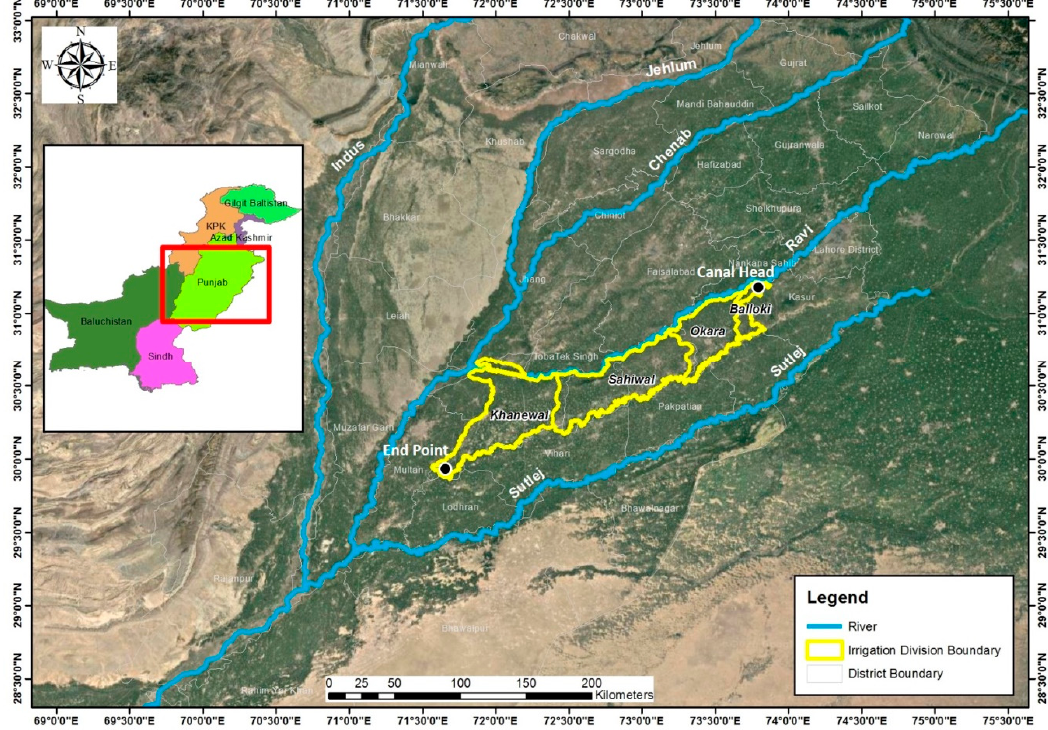
Figure 2. Study area map.